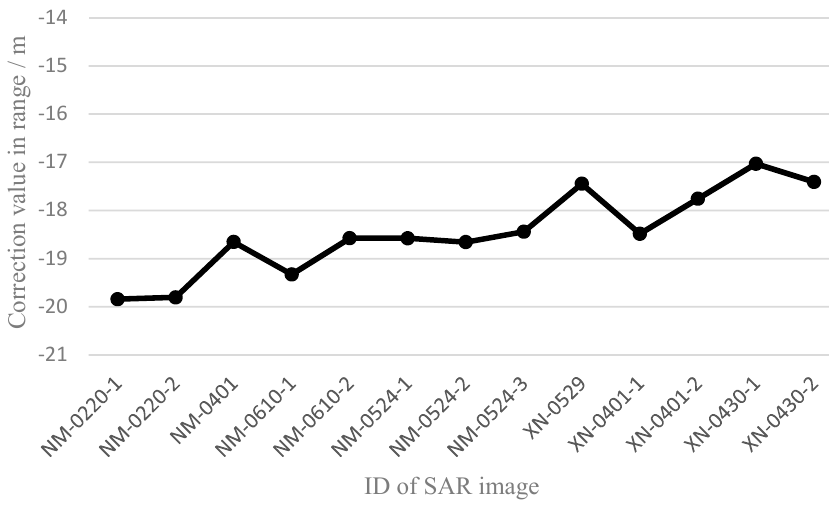
Figure 4. Variation trend of correction values in the range direction.